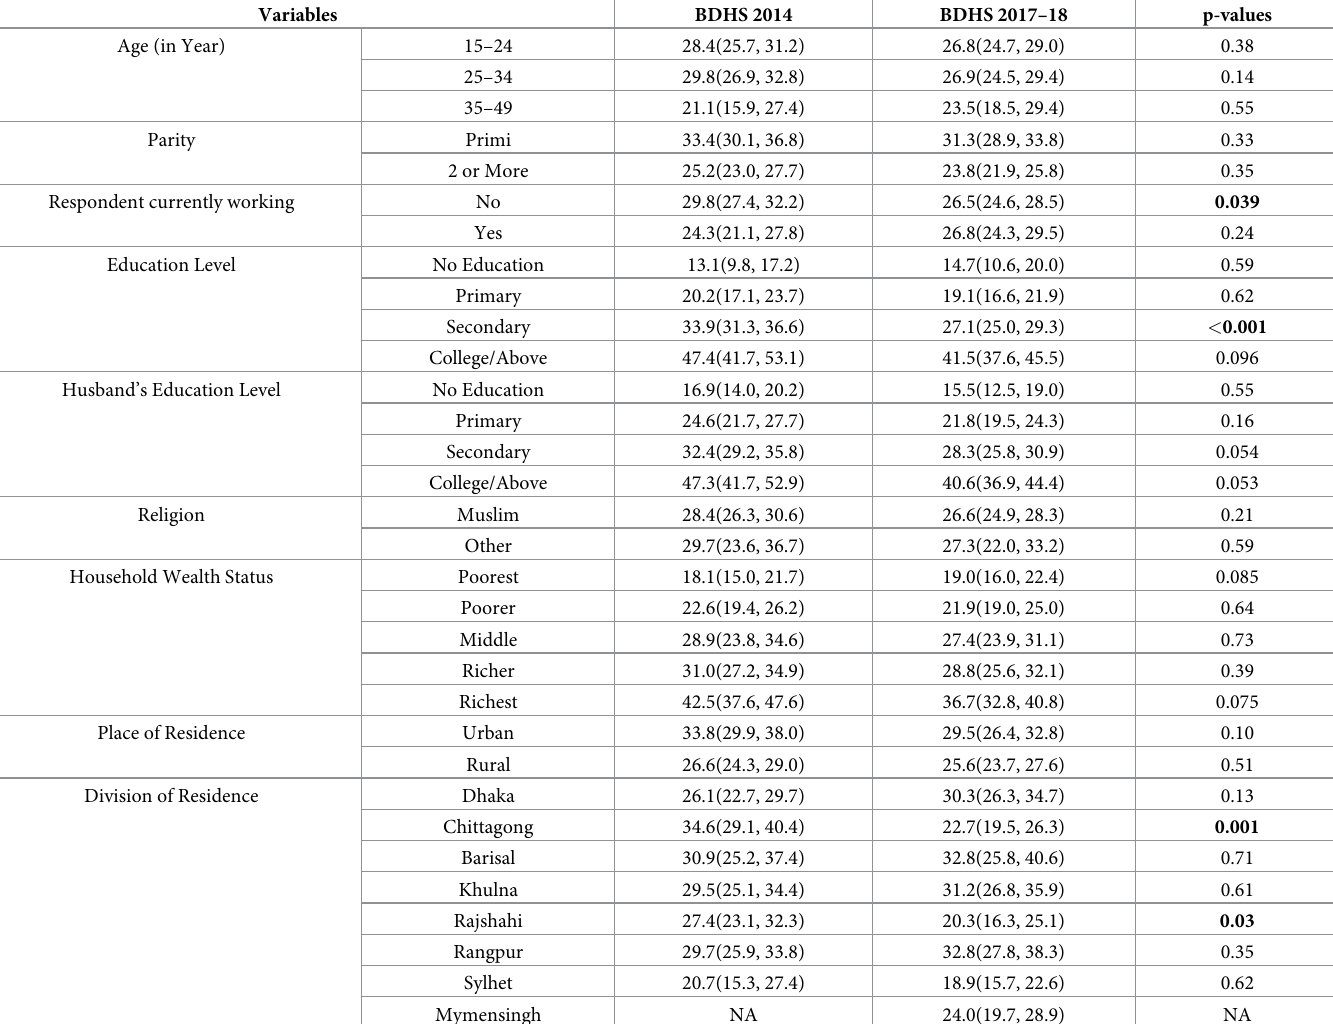
Table 2. Socio-demographic distribution of mobile phone usage prevalence (95% CI) among respondents for pregnancy by survey period, BDHS 2014 and BDHS